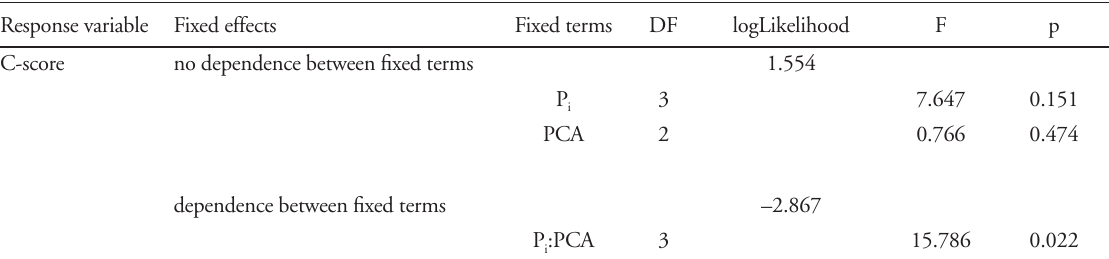
Table 2. Generalized linear models of the relationship between the temporal co-occurrence of macroinvertebrates on leaf detritus (C-score), connectivity (P ) and the environmental variability given by the first axis of the PCA ordination of sampling parameters i (Appendix 2, Fig. A1). Response variable Fixed